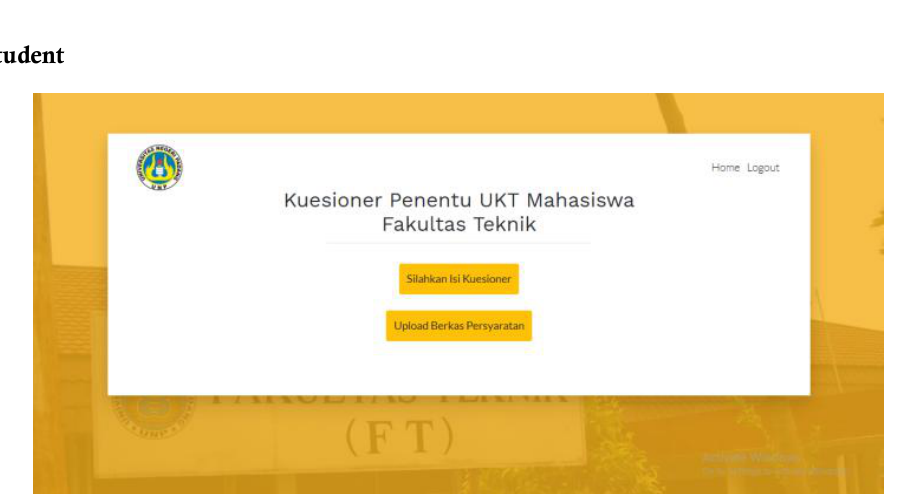
Figure 9. Student Main Page